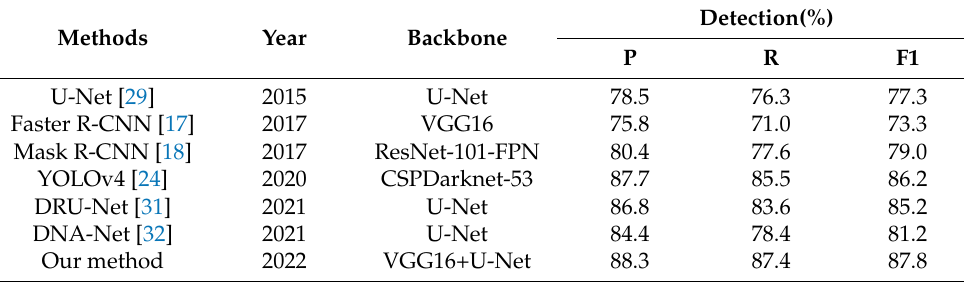
Table 3. Comparison of detection performance on TIV